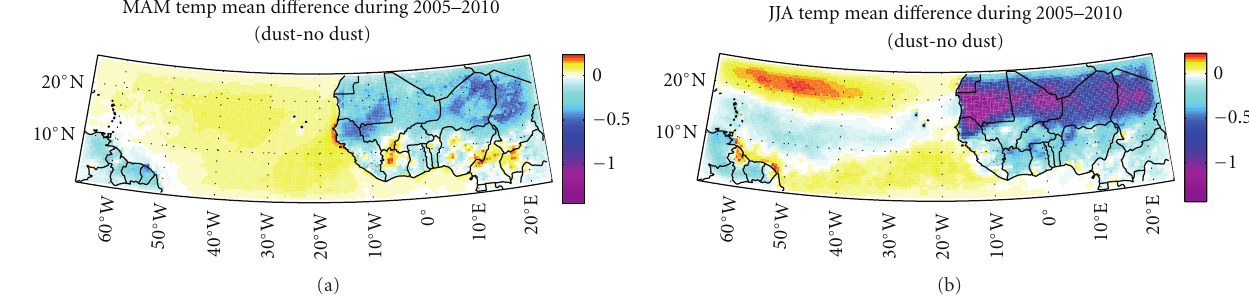
Figure 12: E ff ect of dusts on temperatures in ◦ C at the surface during the months of (a) MAM and (b) JJA. Cooling is indicated with cool colors while warming with hot colors.